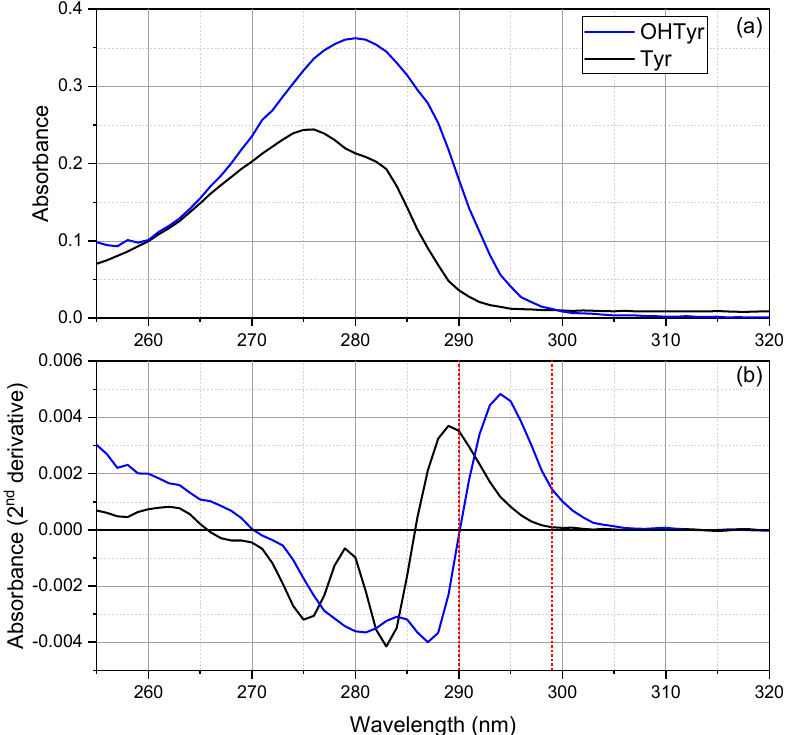
Figure 1. Mean spectra ( a ), and second derivatives ( b ) of OHTyr and Tyr solutions in natural deep eutectic solvent (NADES) (20 mg L − 1 , n = 3). The red dotted reference lines correspond to the wavelengths selected for the calibration curves.